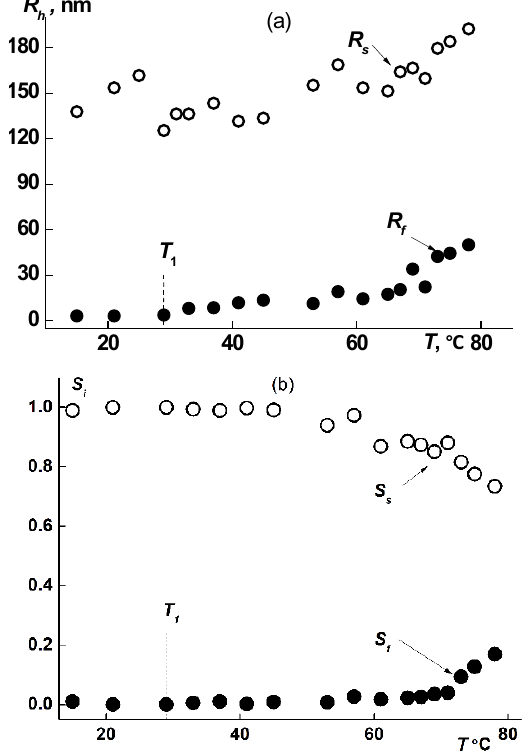
Figure 8. Progress of hydrodynamic size ( a ) and S i ( b ) (i is f or s) upon heating for fast and slow modes in sample 1 aqueous solution at c = 0.0047 g/cm 3 .